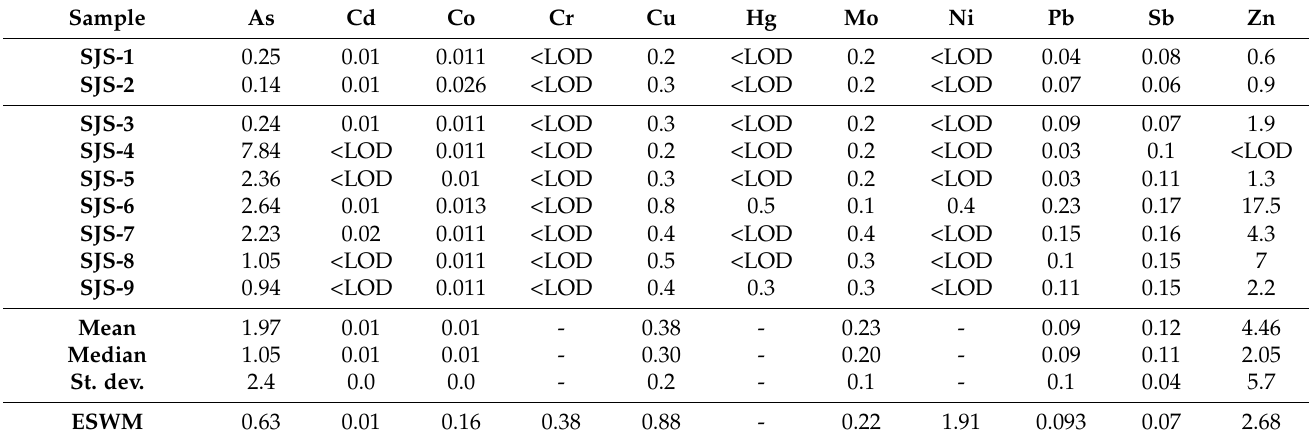
Table 4. Concentrations of PTEs ( µ g/L) in stream water compared. European stream water medians (ESWM) [55] are shown for